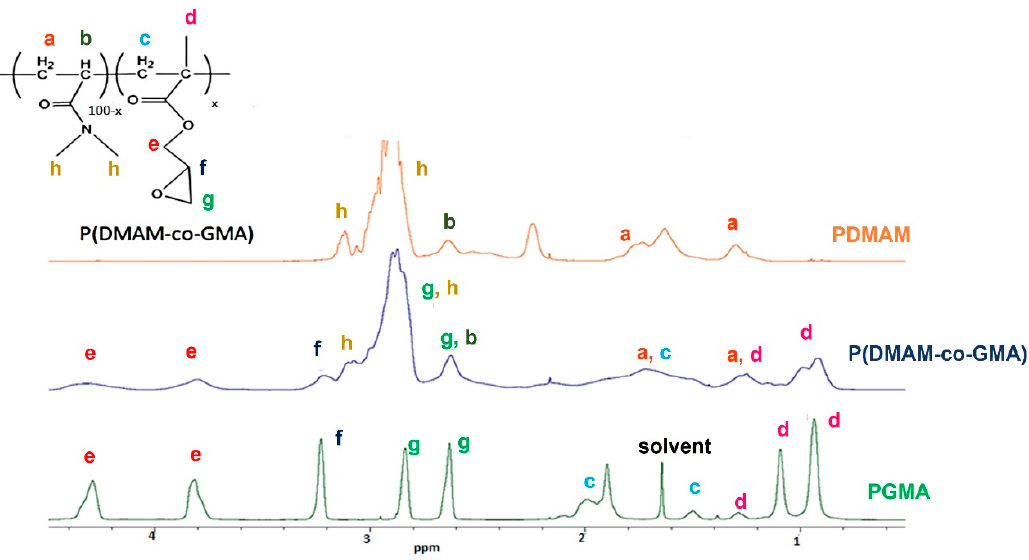
Figure 2. 1 H NMR spectrum of the copolymer P(DMAM-co-GMA) in CDCl 3 in comparison with the spectra of the two homopolymers, PDMAM and PGMA.